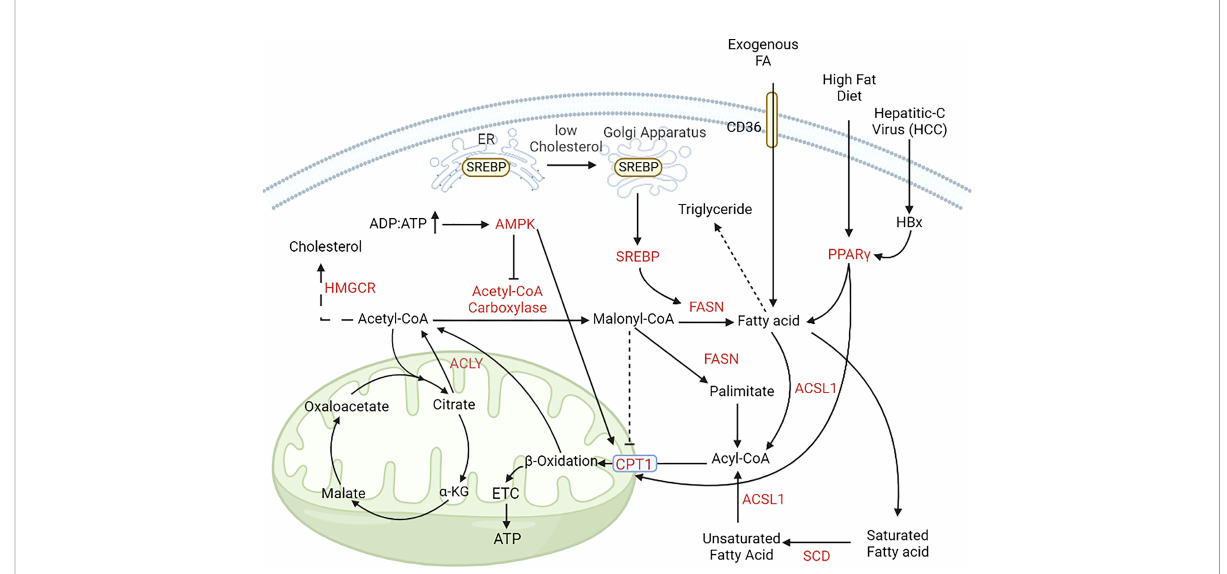
FIGURE 4 Alterations in lipid metabolism during cancer progression. In cancer cells, lipogenesis and lipolysis is controlled by the pool of ADP and ATP. In nutrient-rich conditions (ADP, ATP ratio is low); acetyl, CoA is converted to free fatty acids with the help of acetyl, CoA carboxylase and FASN. In nutrient-deprived conditions (ADP, ATP ratio is high), free fatty acids enter the mitochondria with the help of CPT1 and CPT1A and help in energy generation (195, 196). [FASN, Fatty acid synthase; CPT1, Carnitine palmitoyl transferase 1; CPT1A, Carnitine palmitoyl transferase 1A; GLUT, Glucose transporter; PPAR g , peroxisome proliferator activator receptor g